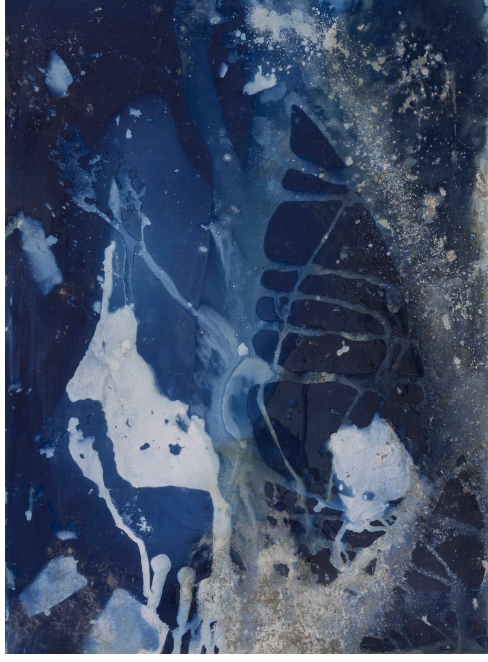
Figure 10: Downwaste (Grinnell I) , 2019. Cyanotype on paper 30"x22". Courtesy of Jonathan Marquis. Downwaste gallery available at: